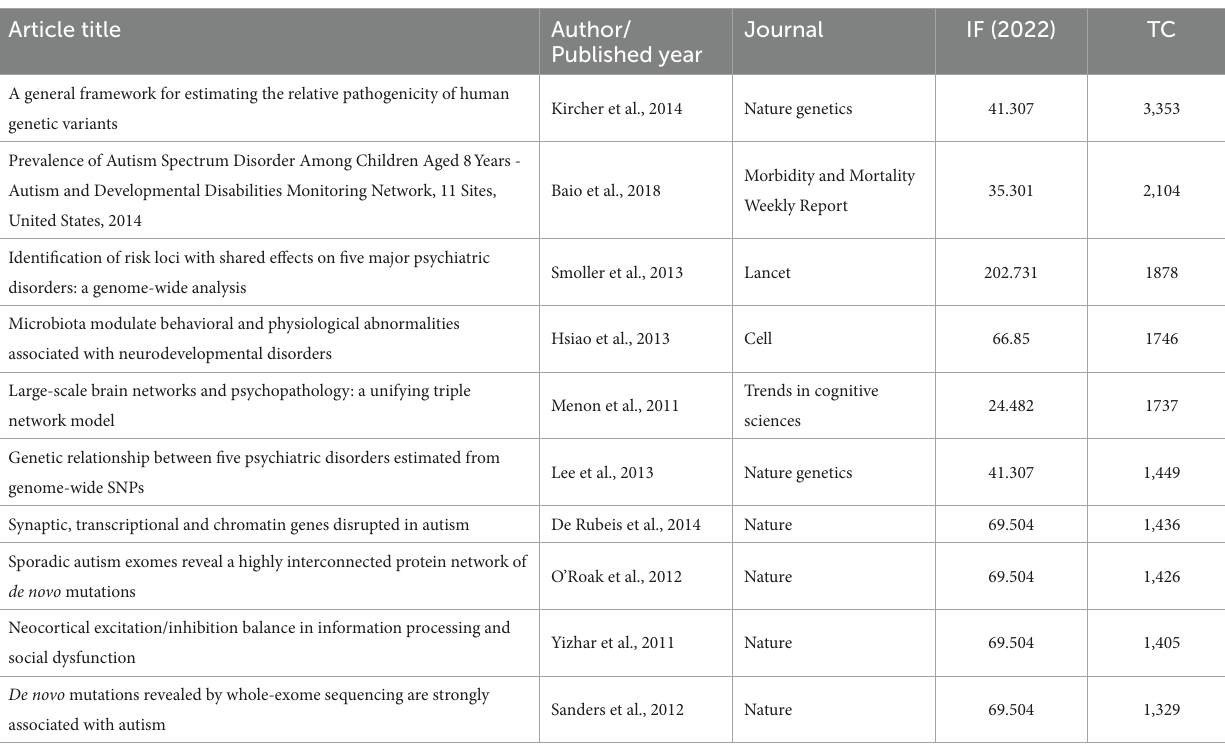
TABLE 5 Detail of top 10 citation